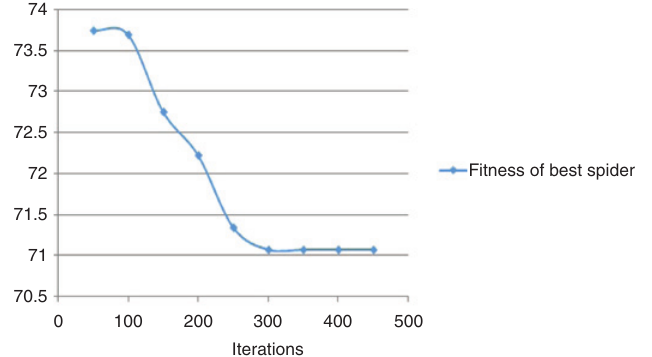
Figure 5: Convergence Analysis for Wine Data Set: SSO.